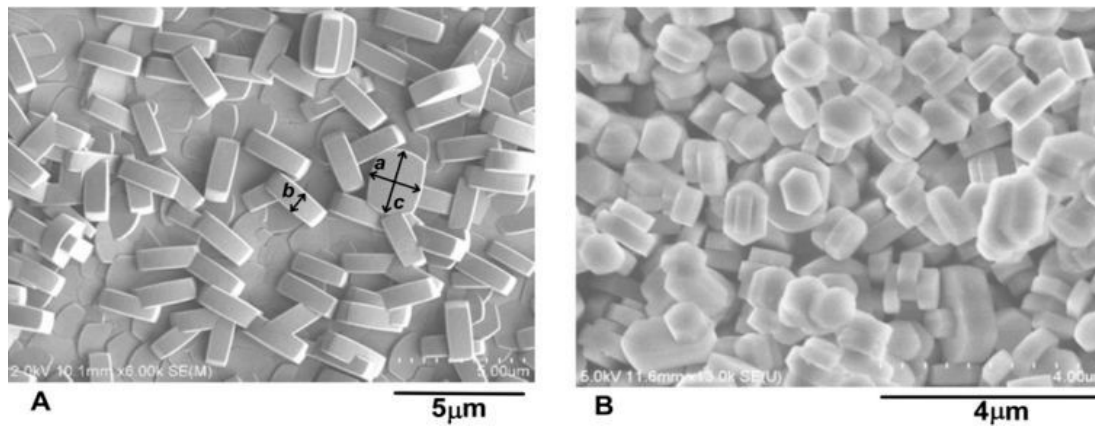
Figure 1. SEM images of SF-500 ( A ) and SC-500 ( B ). The surface of the film is covered by crystals with dimensions a = 1.0 ± 0.1 μ m, b = 0.5 ± 0.0 μ m, and c = 1.4 ± 0.1 μ m (panel A).